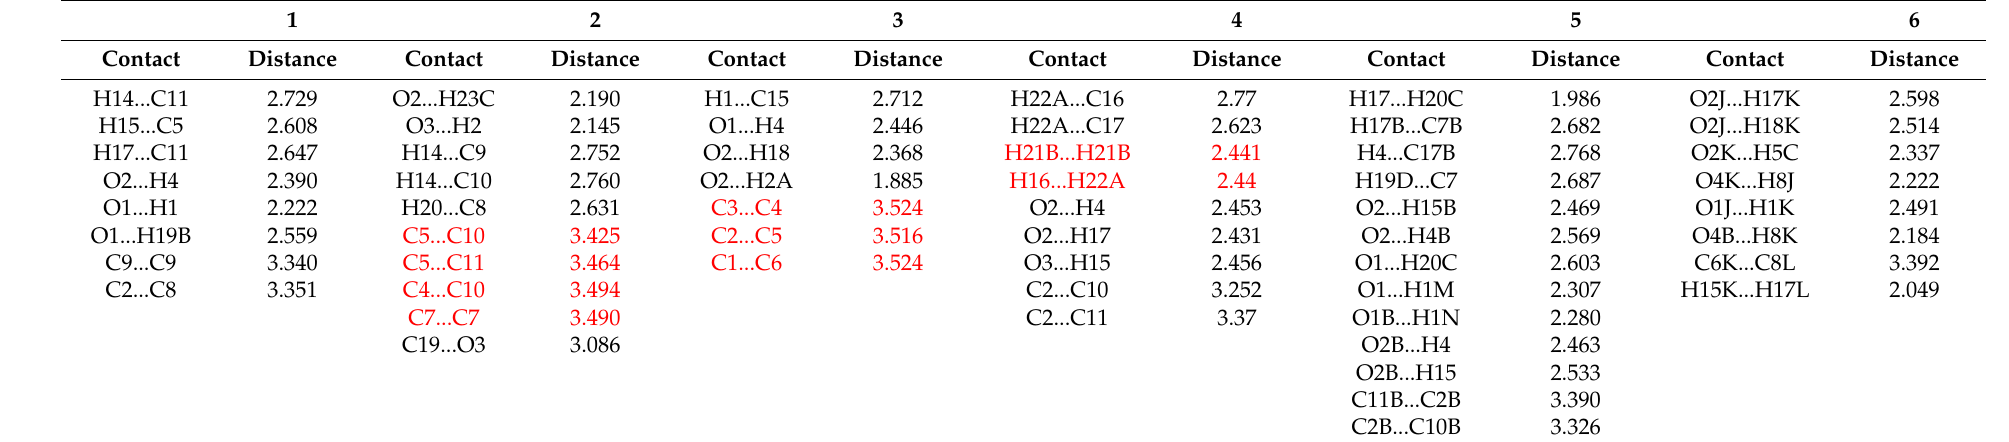
a Values in red for contacts with longer distances than the VDWs radii